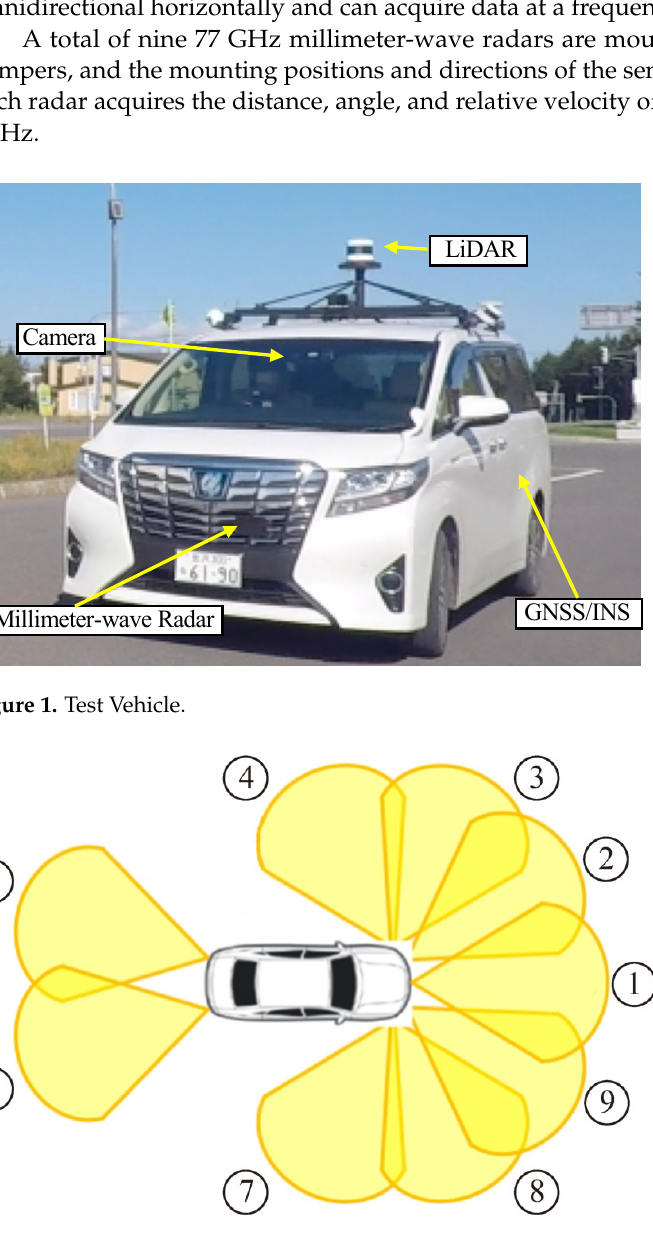
Figure 2. Sensor layout of millimeter-wave radars. The vehicle has nine radars. The numbers are sensor